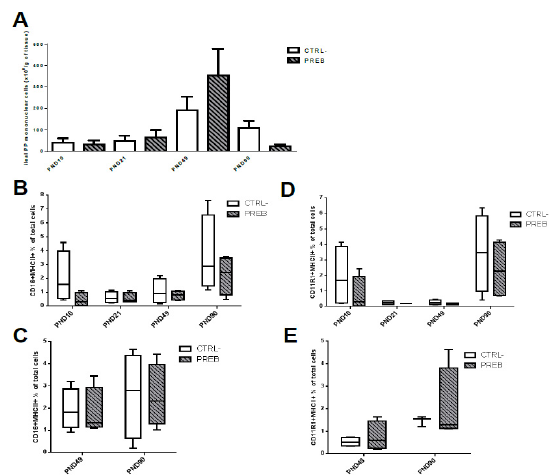
Figure 4. Sow diet prebiotic supplementation impacted ileal and jejunal PP cell numbers, but not the proportion of resident and migrating APC. Datasets were analyzed using the non-parametric Mann-Whitney test, for each age. ( A ) Numeration of mononuclear immune cells ( × 10 6 per g tissue) in il-PP of CTRL- ( n = 4, empty black bar) and PREB ( n = 4, black hatched grey bar) piglets at PND10, PND21, PND49 and PND90. ( B ) CD16 + MHCII + proportion (% of total immune cells measured by flow cytometry) in CTRL- and PREB il-PP at PND10, PND21, PND49 and PND90. ( C ) CD16 + MHCII + proportion (% of total immune cells) in CTRL- ( n = 4, empty black bar) and PREB ( n = 4, black hatched grey) jej-PP at PND49 and PND90. ( D ) CD11R1 + MHCII + proportion (% of total immune cells) in CTRL- ( n = 4, empty black bar) and PREB ( n = 4, black hatched grey bar) il-PP at PND10, PND21, PND49 and PND90. ( E ) CD11R1 + MHCII + proportion (% of total immune cells) in CTRL- ( n = 4, empty black bar) and PREB ( n = 4, black hatched grey bar) jej-PP at PND49 and PND90.